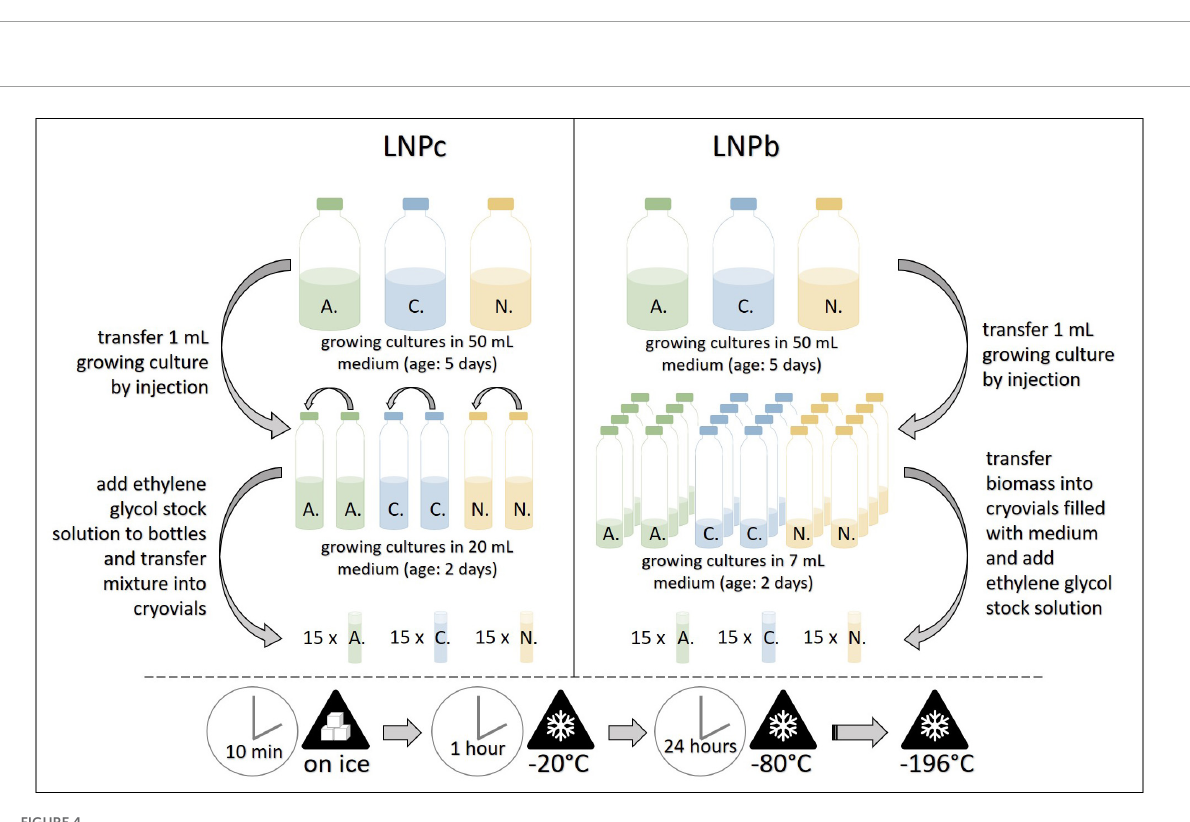
FIGURE4 Workflow for the cryopreservation protocols LNPc (left) and LNPb (right) . A., Anaeromyces mucronatus ; C., Caecomyces sp.; N., Neocallimastix cameroonii. –196 ◦ C refers to preservation in liquid nitrogen. LNPb, preservation of liquid culture with ethylene glycol stock solution in liquid nitrogen; LNPc, preservation of liquid culture with ethylene glycol stock solution in liquid